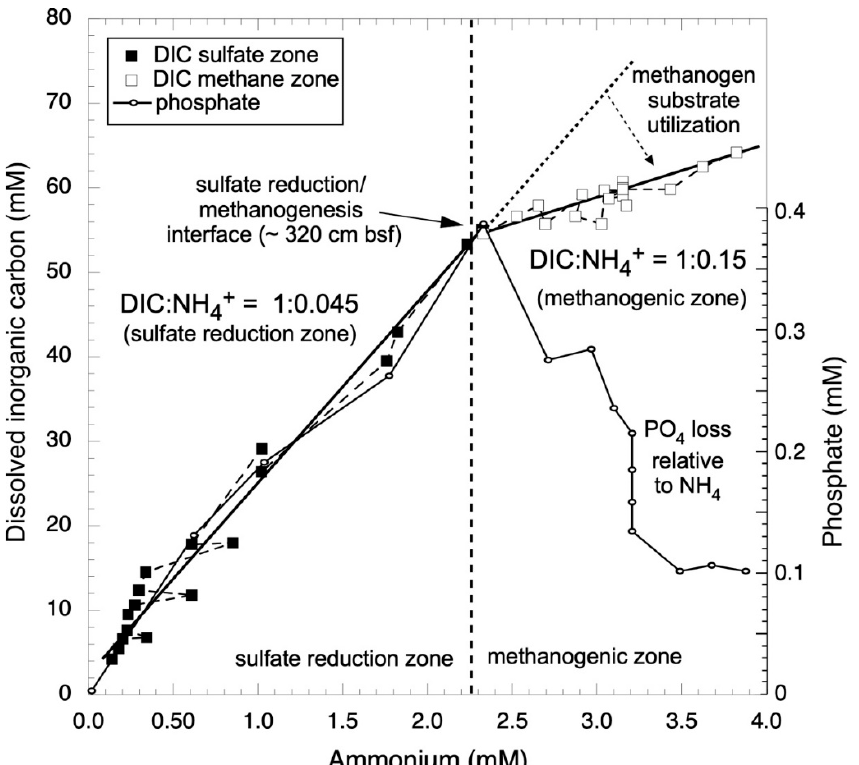
Figure 4. Stoichiometry between dissolved inorganic carbon (DIC) and phosphate with ammonium in core ANT 1138-2, illustrating the linear C:N and N:P relationships within the diagenetic sulfate-reduction zone (SRZ). The change in C:N beneath the SRZ is due to methanogenic uptake of DIC. The dramatic loss in phosphate relative to ammonium beneath the SRZ is clearly evident.